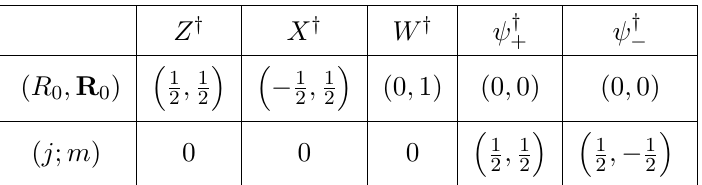
3) sector. One can also calculate these |